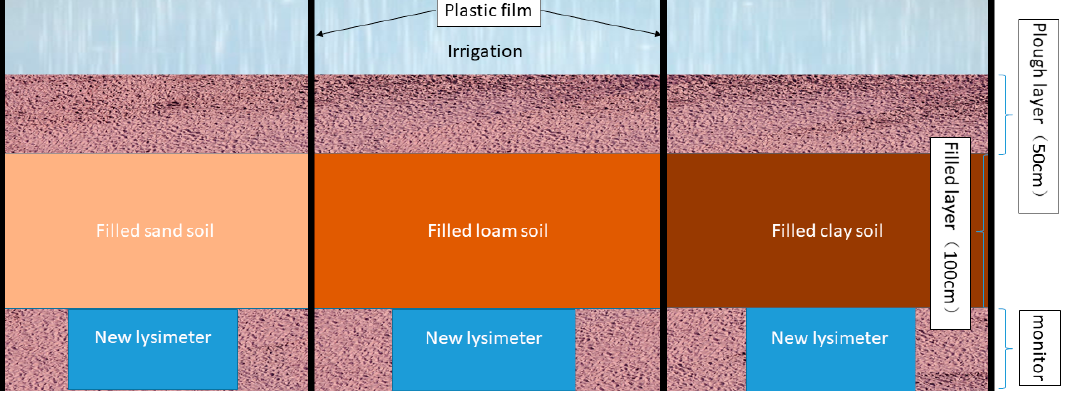
Figure 2. Three kinds of soil substitutions were carried out for the original soil. Each plot is separated by plastic film as an independent system.